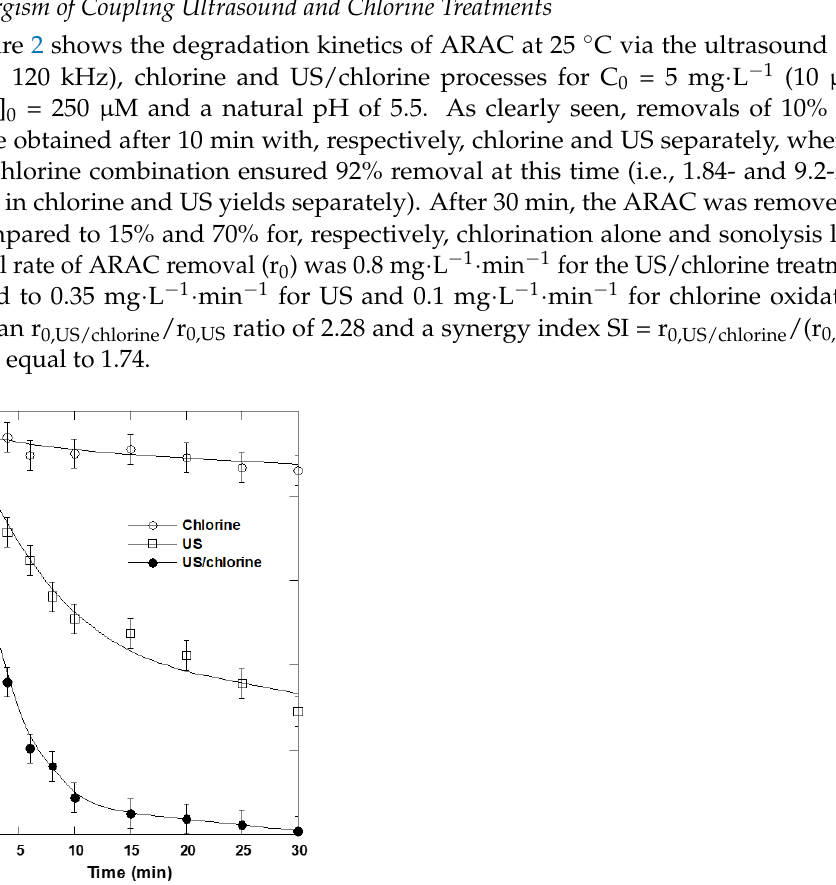
Figure 3. Changes in UV-Vis spectrums during the treatment of ARAC via ultrasound (US) ( a ) and US/chlorine ( b ) processes (conditions: C 0 = 5 mg·L −1 (10 µM), [chlorine] 0 = 250 µM, V = 150 mL, pH 5.5, temperature: 25 ± 1 °C, frequency: 600 kHz, power: 120 W).